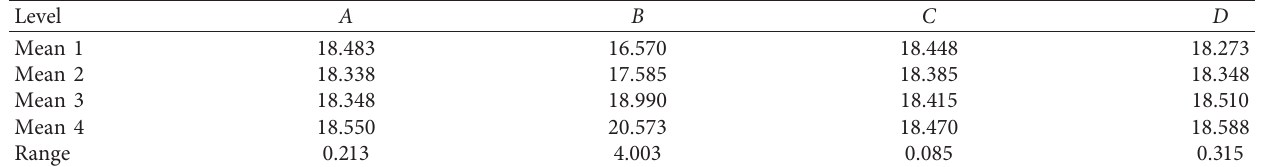
Figure 17: Nephogram of thinning rate of A Table 5: Range analysis table of maximum thickening